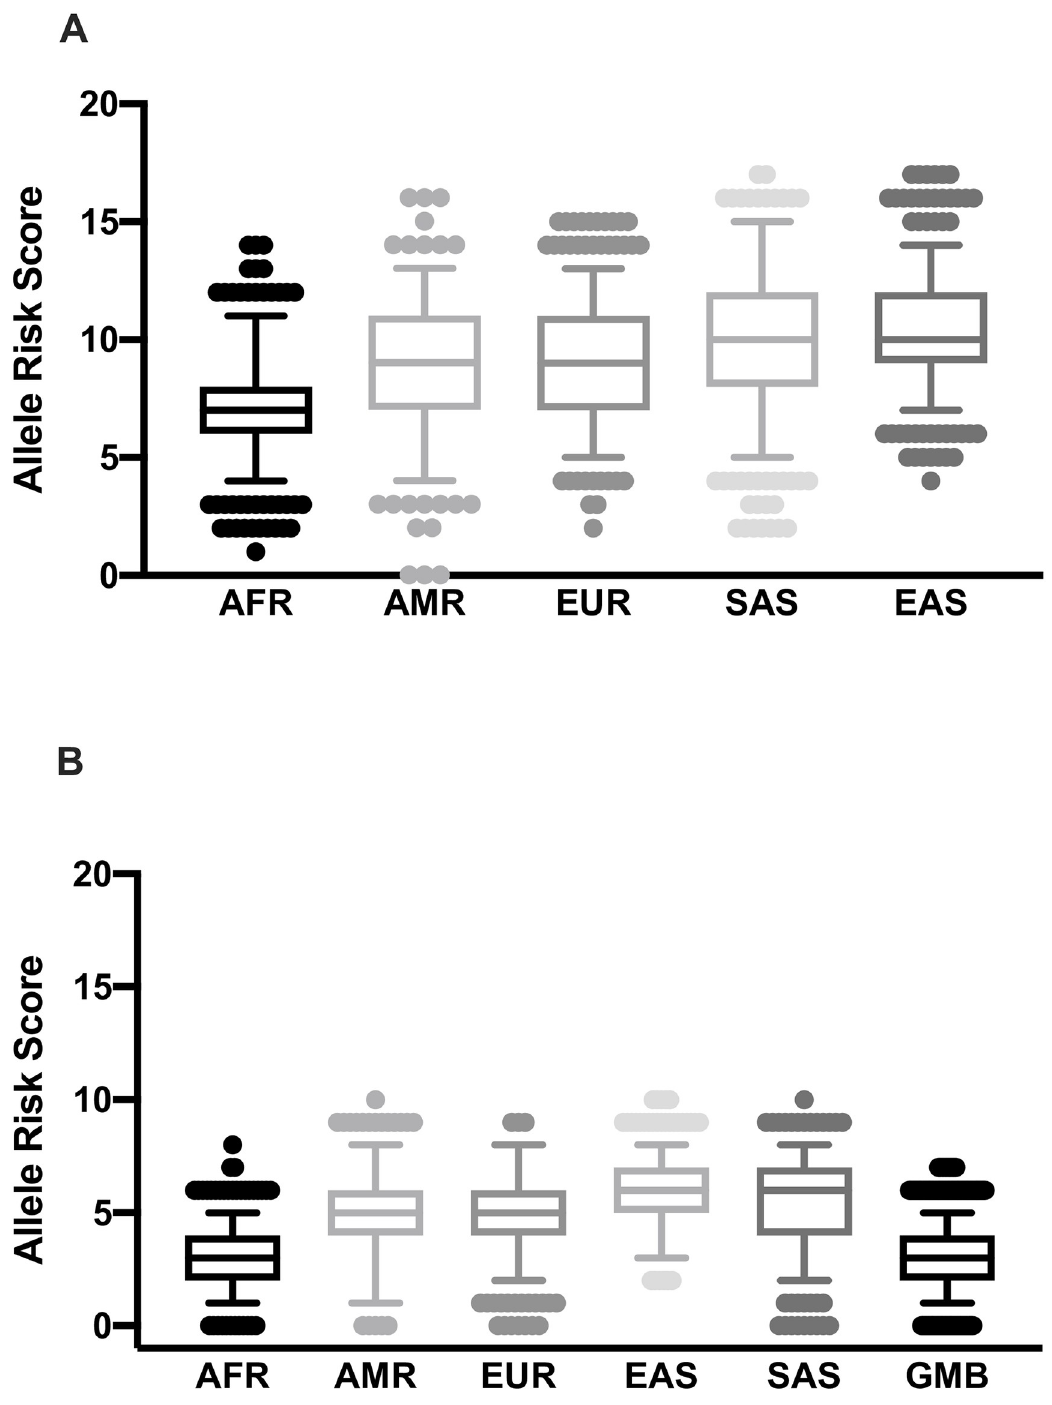
Fig 6. Distribution of the number of low iron risk alleles across global populations. (A) Distribution of the number of low iron risk alleles in eleven SNPs associated with low iron status across five populations. (B) Distribution of the number of low iron risk alleles in six SNPs with genotype data in the MRC Keneba Biobank population. Designation of the allele (risk or not) was determined by their previously published information as presented in S1 and S2 Tables. AFR, African; EUR, European; AMR, American; EAS, East Asian; SAS, South Asian.